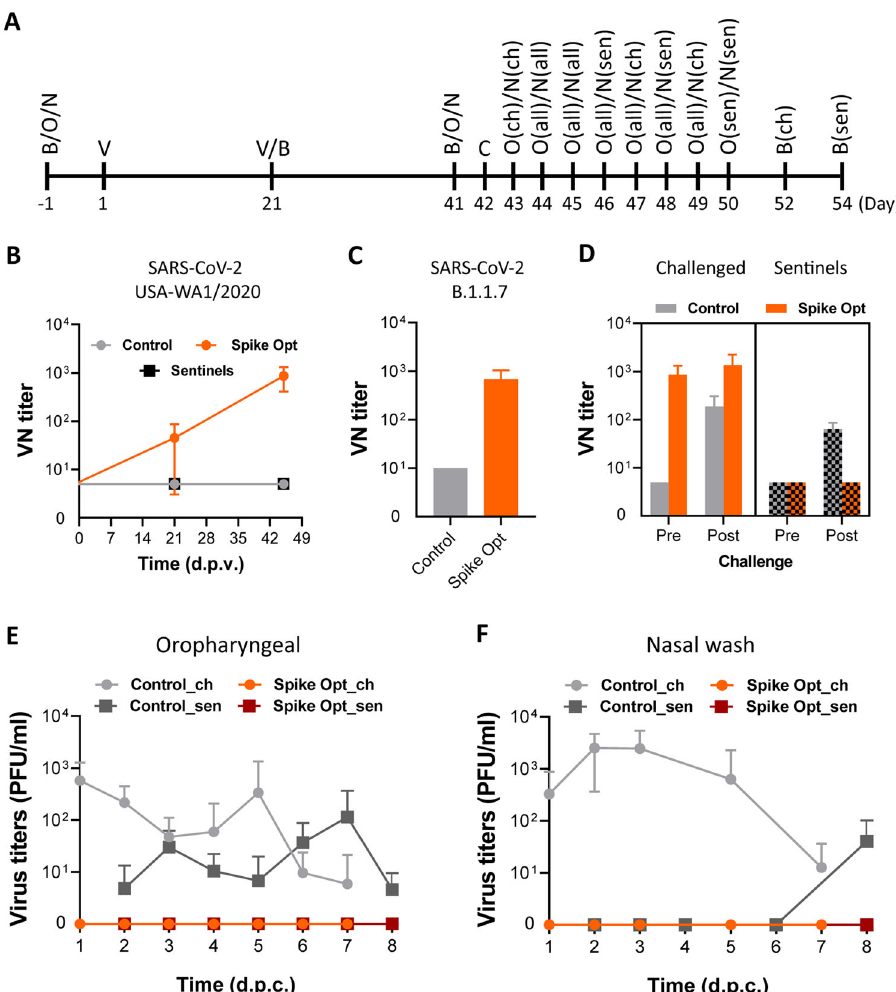
Fig. 4 Vaccination-challenge experiment in cats. A Timeline of animal handlings. V = vaccination, B = blood sampling, O = oropharyngeal swabs, N = nasal swab, (all) = all animals, (ch) = only challenged animals, (sen) = only sentinel animals. B Serum neutralizing antibody titers determined using a SARS-CoV-2 virus neutralization (VN) assay at 21- and 42-days post vaccination (d.p.v.) in the non-vaccinated (Control) or Spike Opt vaccinated cats. C Serum neutralizing antibody titers determined using a VN test using the SARS-CoV-2 B.1.1.7 variant virus at 42- days post vaccination in the non-vaccinated (Control) or Spike Opt vaccinated cats. D Serum neutralizing antibody titers were determined using a SARS-CoV-2 virus neutralization assay at the day of challenge, 42-days post vaccination and 14 days post challenge and shown for challenged control vaccinated animals (solid grey), non-vaccinated sentinel animal co-housed with control vaccinated animals (grey with pattern), Spike Opt antigen vaccinated animals (solid orange), or non-vaccinated sentinel animals co-housed with Spike Opt antigen vaccinated animals (orange with pattern). SARS-CoV-2 virus titers were measured in oropharyngeal swabs ( E ) or nasal swabs ( F ) at 1 − 8 days post challenge (d.p.c.) expressed in PFU/ml. All experiments were performed on Vero E6